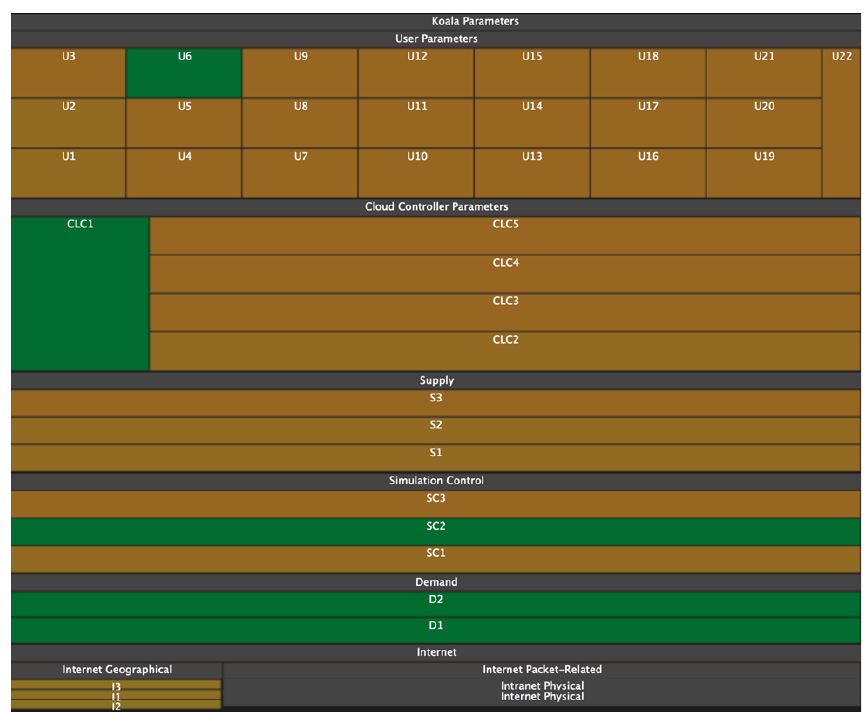
Figure 5. With a large scatter of parameter values, rectangles with a large width and height ratio may appear on treemaps [43].